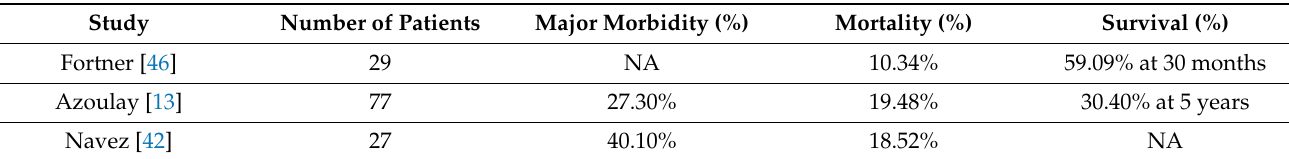
Table 2. Major studies on in situ hypothermic perfusion technique (excluding case series with less than 5 cases or where technique-specific outcomes were not